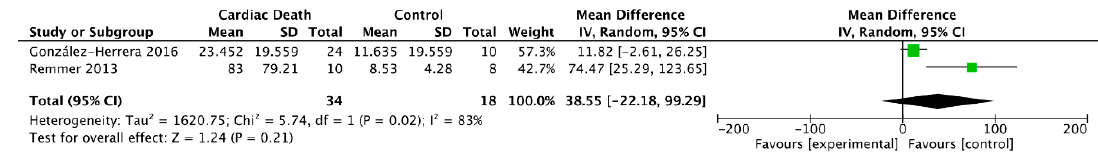
Figure 3. Forest plot of cTn T in pericardial fluid between cardiac death and control groups.